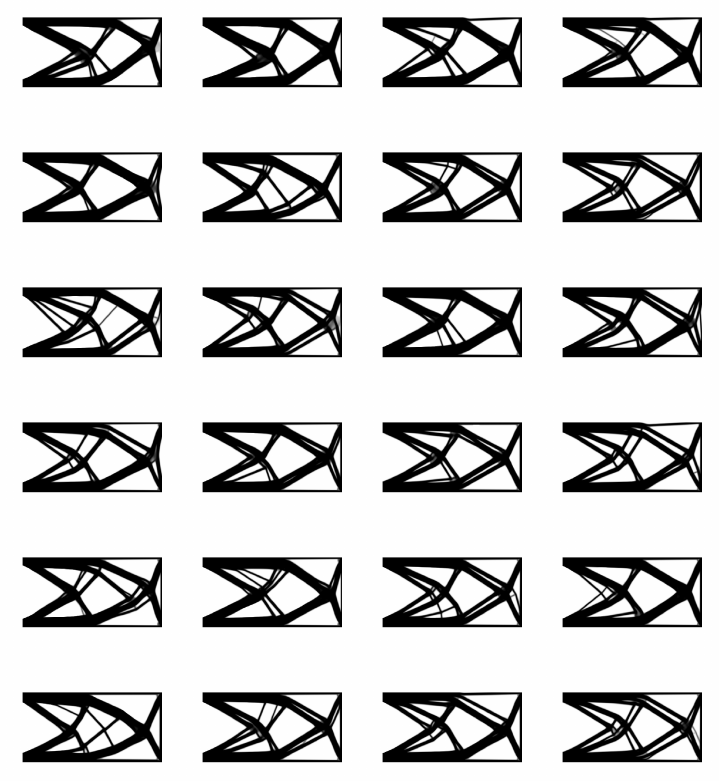
Figure 14. Results for test example E.